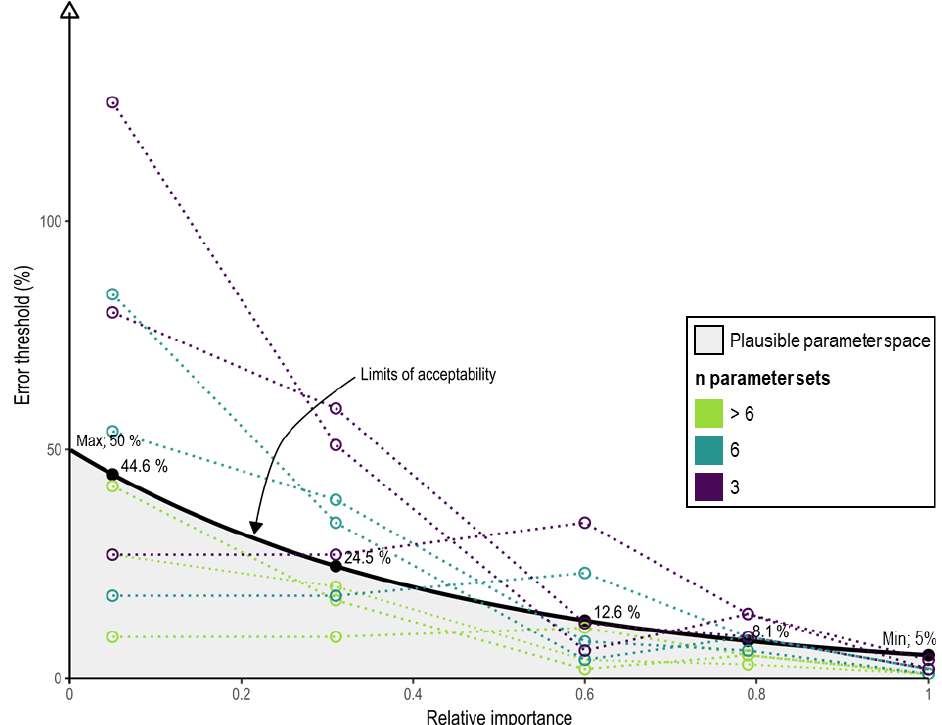
Figure 2. Conceptualization of the limits of acceptability, depicted here as the log-linear relationship between relative importance and the allowable (absolute) error thresholds per indicator and covariance. The limits of acceptability are reduced until n = 3 parameter sets lie within the plausible parameter space. In this example, the error threshold ranges from 5%, where the relative importance is one, to a maximum of 50%. The maximum allowable error per example indicator is